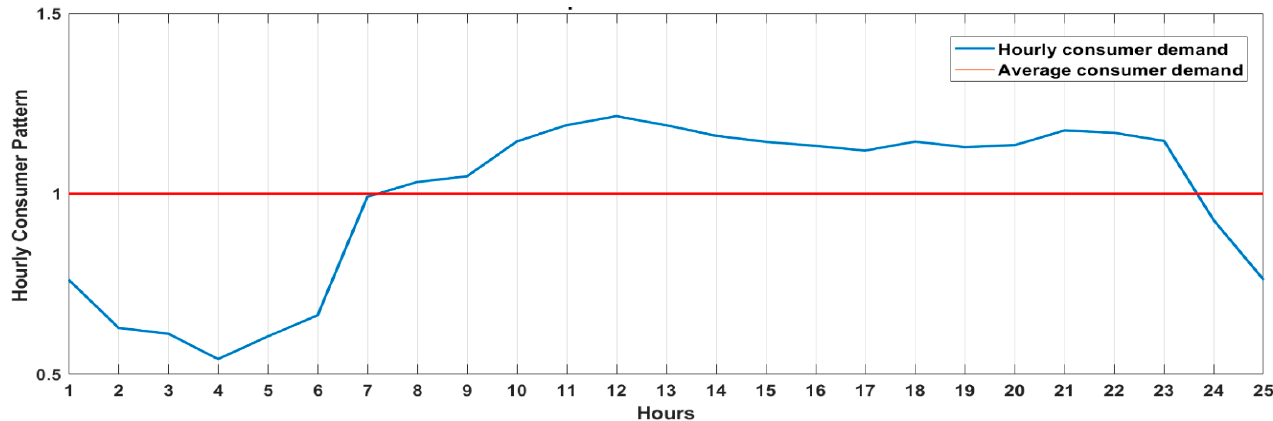
Figure 3. Consumer pattern from WDN “SF812” in the tank.